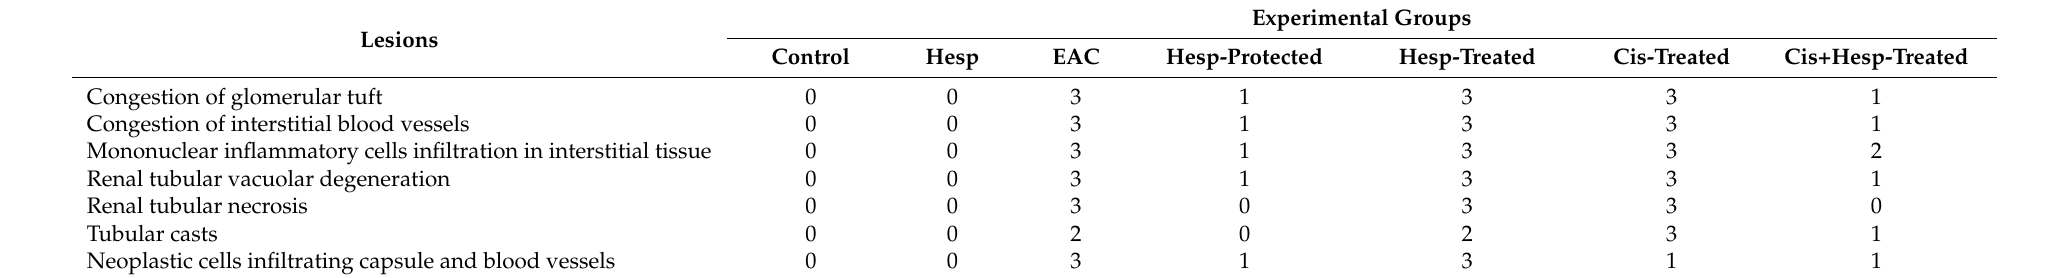
Table 4. Scoring of histopathological alterations in the kidneys of the different treated